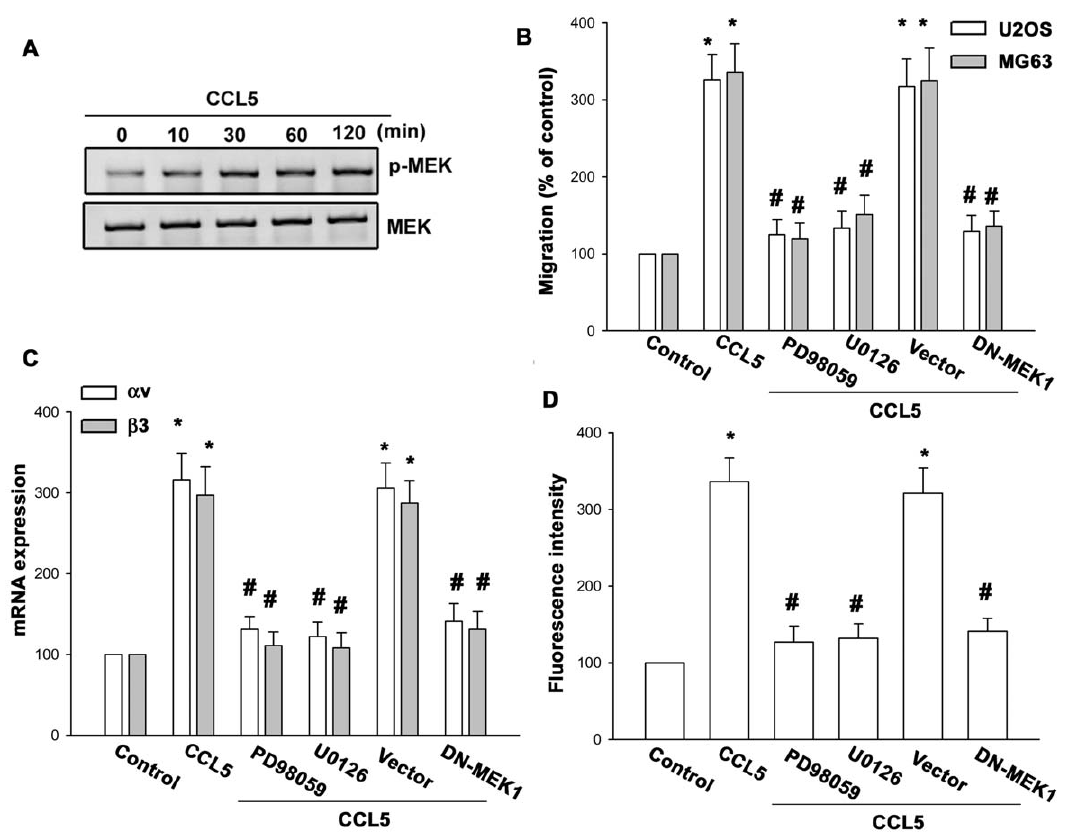
Figure 3. MEK is involved in CCL5-mediated migration in human osteosarcoma cells. (A) MG63 cells were incubated with CCL5 for indicated time intervals, and p-MEK expression was determined by Western blotting. (B–D) MG63 or U20S cells were pretreated with PD98059 and U0126 for 30 min or transfected with dominant negative (DN) mutant of MEK1 for 24 h followed by stimulation with CCL5. The in vitro migration and integrin expression was examined by Transwell, qPCR, and flow cytometry analysis. Results of five independent experiments performed are expressed. Results are expressed as the mean 6 S.E. *, p , 0.05 compared with control; # , p , 0.05 compared with CCL5-treated group.